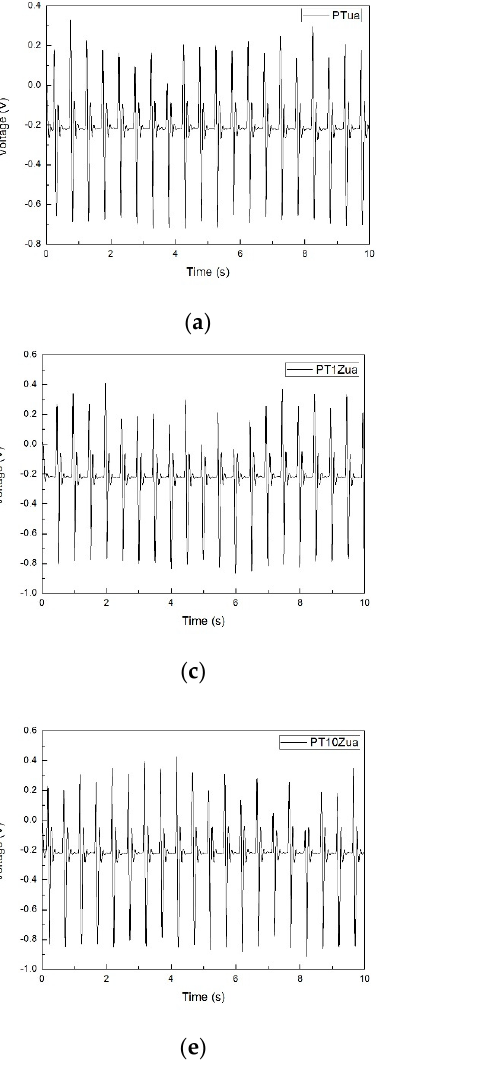
Figure 7. ( a – f ) The auto-clicking test results for six samples. For facilitating a comparison among the performance of all six samples, the peak-to- peak voltage for all samples was measured and is listed in Table 3 and Figure 8. Table 3. Peak-to-peak voltage table. Peak to Peak Voltage (V)